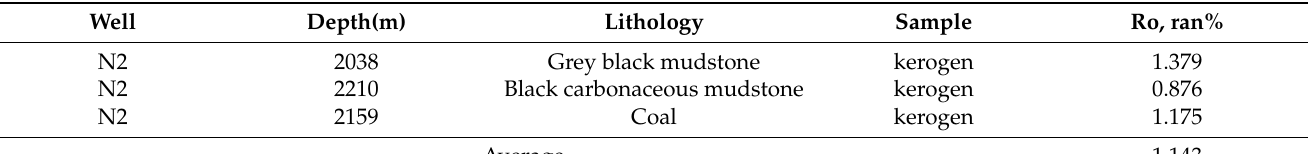
Table 1. Vitrinite reflectance of mudstone kerogen in the Lower Jurassic reservoir in Niudong, northern margin of Qaidam Basin.